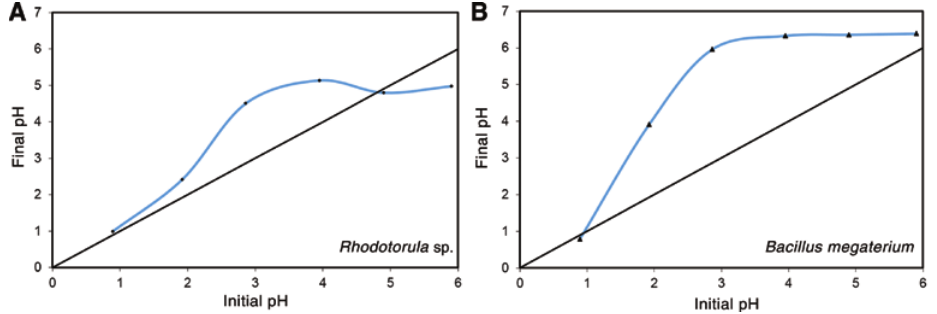
of (A) Rhodotorula sp. and (B) Bacillus megaterium using the pH drift method. Figure 7: Representation of the pH pzc